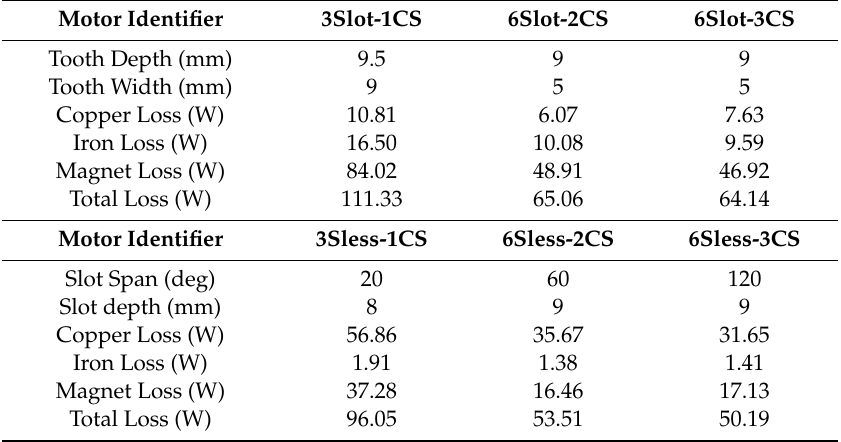
Table 7. Di ff erent loss components of six di ff erent